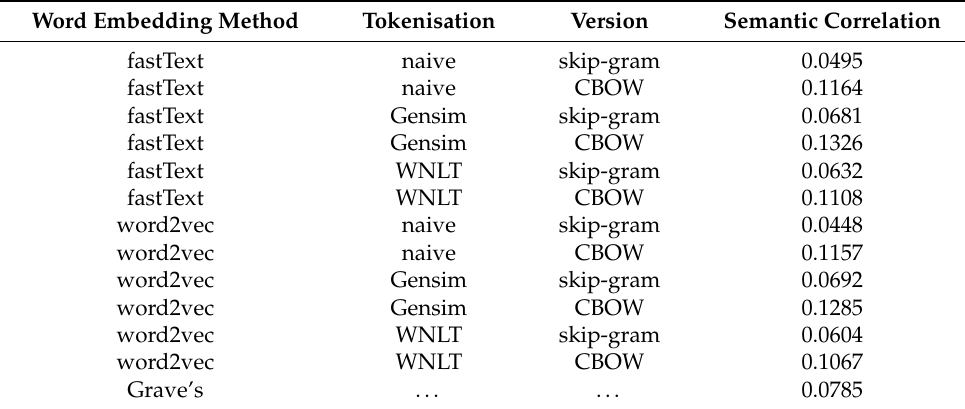
Table 2. The results achieved on the WordSimilarity-353 dataset.